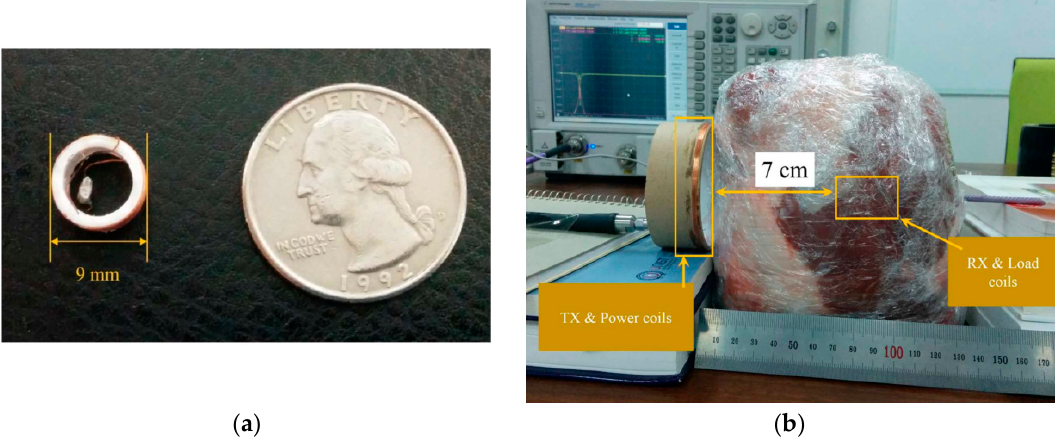
Figure 27. NRMRC WPT system for CE [148]. ( a ) Designed receiver coil with 9 mm diameter. ( b ) Experiment setup with a pork chop. Copyright © 2015, IEEE.